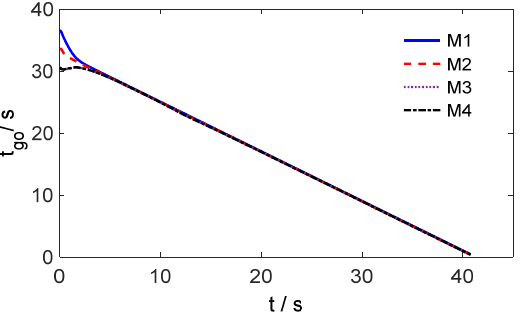
Figure 16. Remaining time error of MPC.